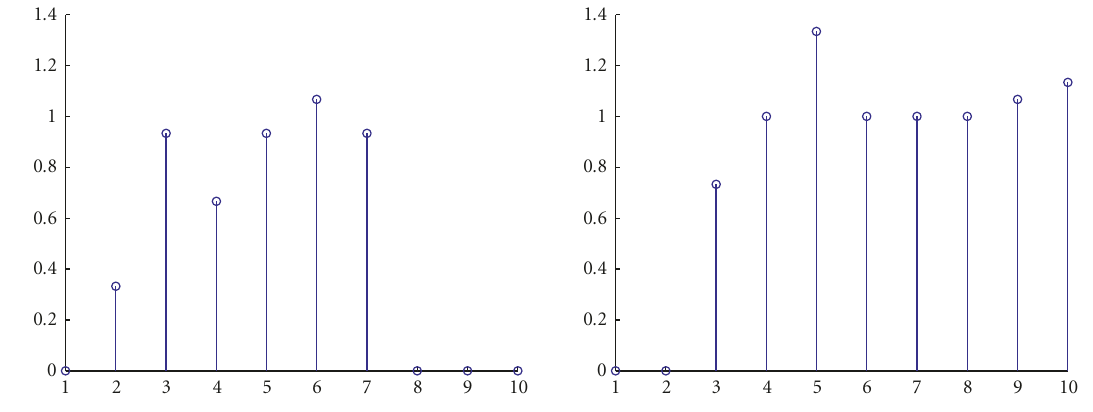
Figure 16: Number of tracked